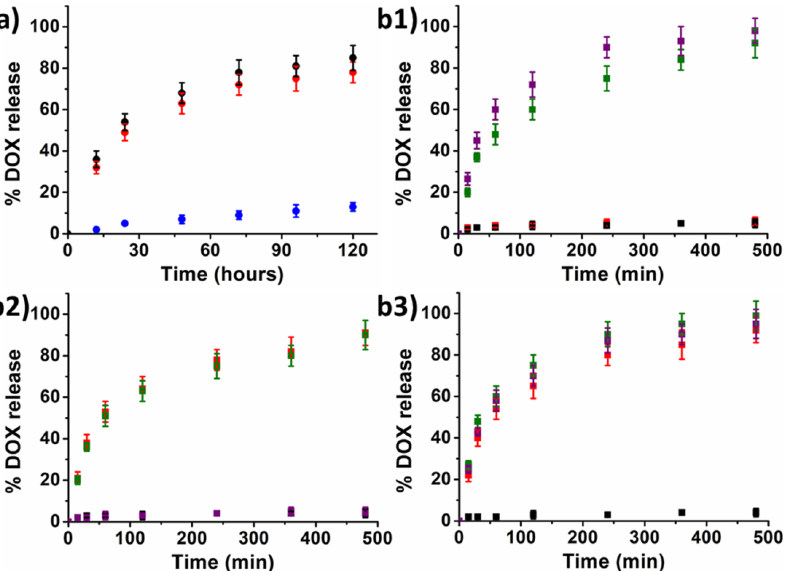
Figure 1. Release kinetics of the di ff erent formulations. ( a ) Release kinetics of the electrostatically immobilized doxorubicin (DOX) (circles) were studied by dispersing MF66-DOX in water (blue), PBS bu ff er (pH 7.4) (black), or sodium acetate bu ff er (pH 4.7) (red). ( b ) Release kinetics of the covalently immobilized DOX (squares) were studied by dispersing MF66-S-S-DOX ( b1 ), MF66-I-DOX ( b2 ), or MF66-S-S-I-DOX ( b3 ), in PBS bu ff er (pH 7.4) containing 1 µ M (black) or 1 mM of 1,4-dithiothreitol (DTT) (purple), or sodium acetate bu ff er (pH 4.7) containing 1 µ M (red) or 1 mM of DTT